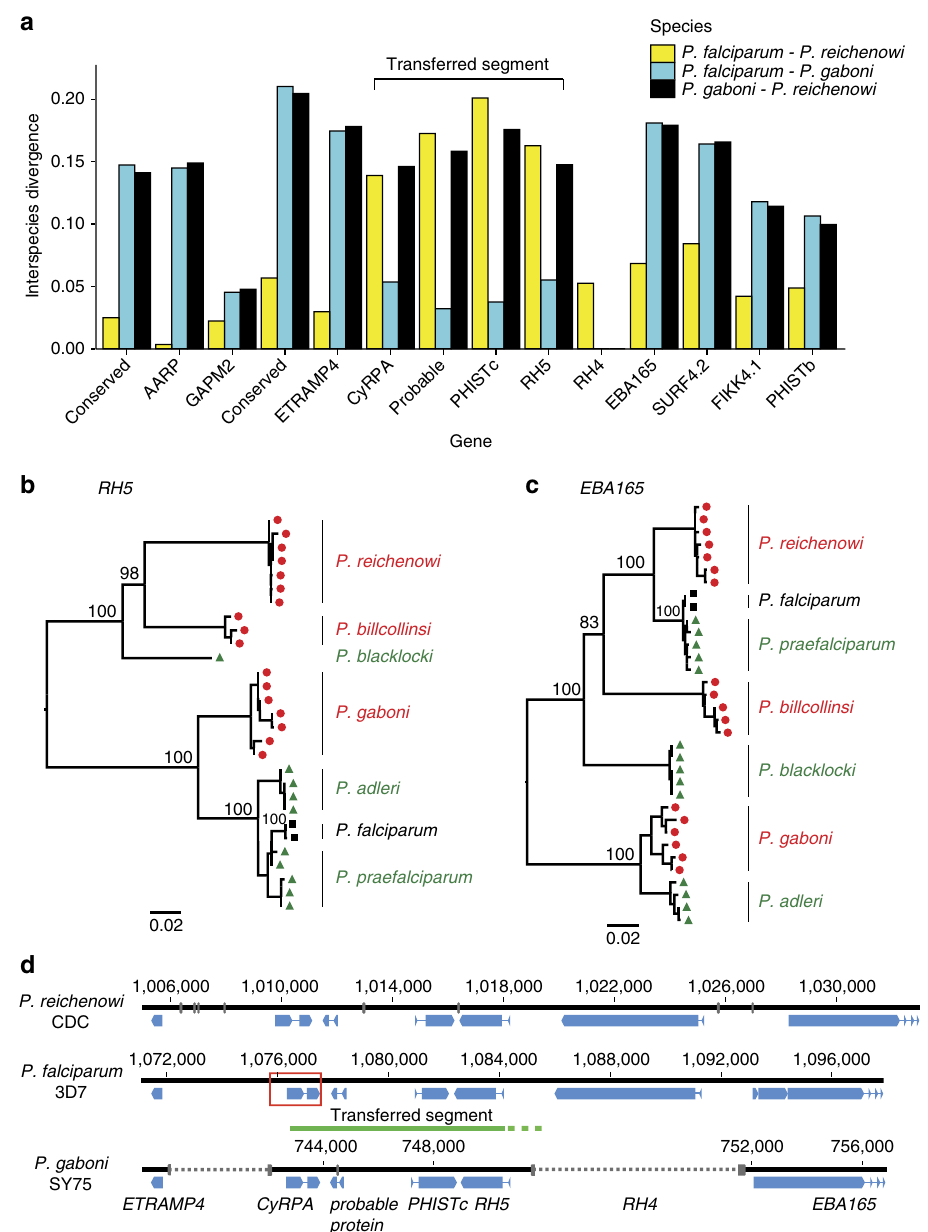
Figure 5 | Horizontal transfer of two essential invasion genes. ( a ) Identification of an 8kb transferred segment on chromosome 4. Inter-species distances (colour coded) are shown for syntenic orthologs of P. falciparum , P. reichenowi and P. gaboni . Four genes, including the essential invasion genes CyRPA and RH5 , exhibit an unusually high P. falciparum – P. reichenowi (yellow) and an unusually low P. falciparum – P. gaboni (aqua) distance, respectively. Genes are ordered by chromosomal location. Since RH4 is absent from P. gaboni (see Supplementary Fig. 4), only the P. falciparum – P. reichenowi distance is shown. ( b , c ) Phylogenetic relationships of Laverania RH5 and EBA165 sequences, revealing an unexpectedly close relationship between the P. praefalciparum/P. falciparum lineage and the P. adleri lineage in RH5 . Laverania parasites are colour coded according to their host species (chimpanzee, red; gorilla, green; human, black). Trees were inferred by maximum likelihood methods 69 . Numbers at internal nodes represent bootstrap support values (only numbers 4 80% are shown). Scale bar, 0.02 substitutions per site (additional phylogenies are shown in Supplementary Fig. 9). ( d ) Schematic diagram of the horizontal transfer region on chromosome 4 in P. reichenowi CDC (top), P. falciparum 3D7 (middle) and P. gaboni SY75 (bottom). Genes are shown in blue; grey bars and broken lines indicate genome gaps (numbering is relative to the first base of chromosome 4). A green line indicates the location of the transferred segment in P. falciparum , with the broken part indicating that the 3 0 -break point is unclear. The region surrounding the 5 0 -break point is highlighted by a red box and shown in greater detail in Supplementary Fig.